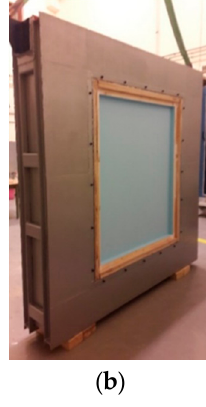
Figure 1. Test rig apparatus and specimen: ( a ) test rig; ( b ) testing frame.